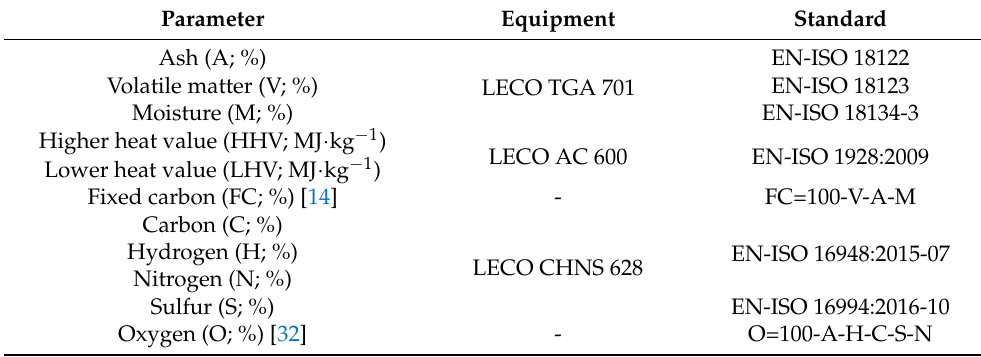
Table 1. Determinations carried out in the